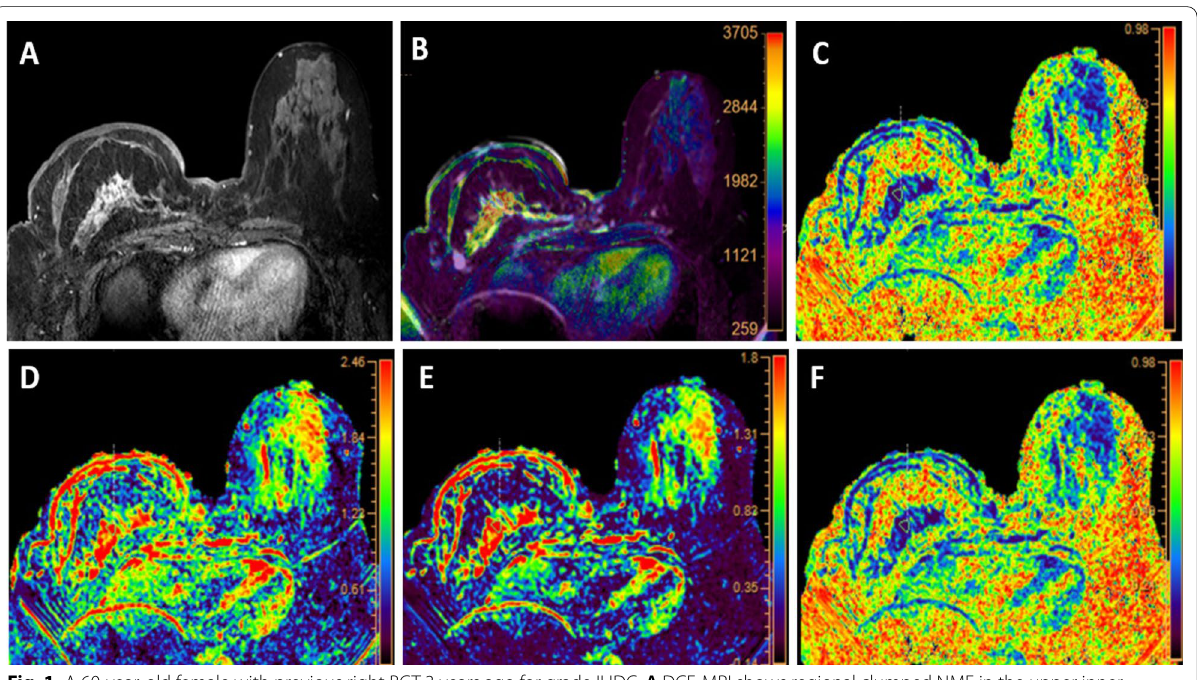
0.7 10 − 3 mm 2 /s. FA 0.4, = × =